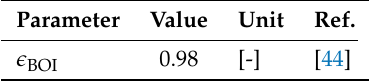
Table A1. Parameter data.